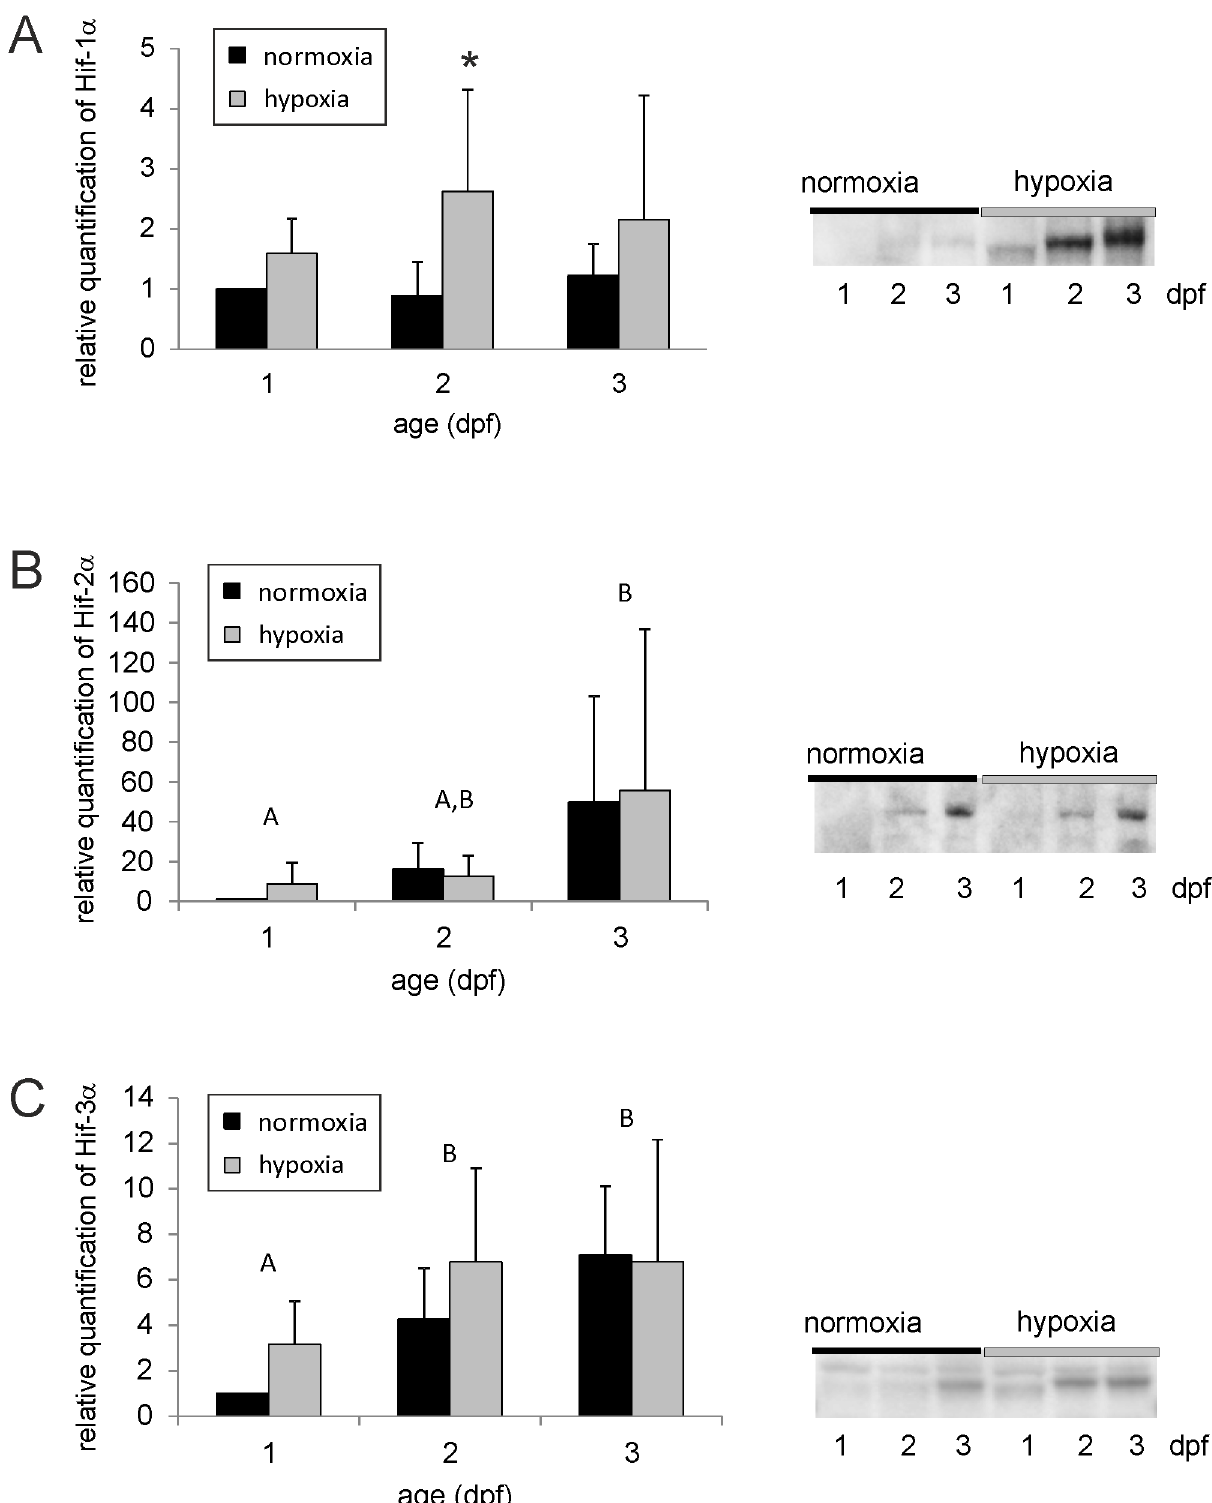
Fig 5. Western blot and relative quantification of zfHif-1 α protein (A), of zfHif-2 α protein (B) and of zfHif-3 α protein (C) of normoxic zebrafish embryos and of embryos incubated under hypoxic conditions (PO 2 = 5 kPa) for 4 hours starting at 28 h after fertilization (1 dpf), 52 h after